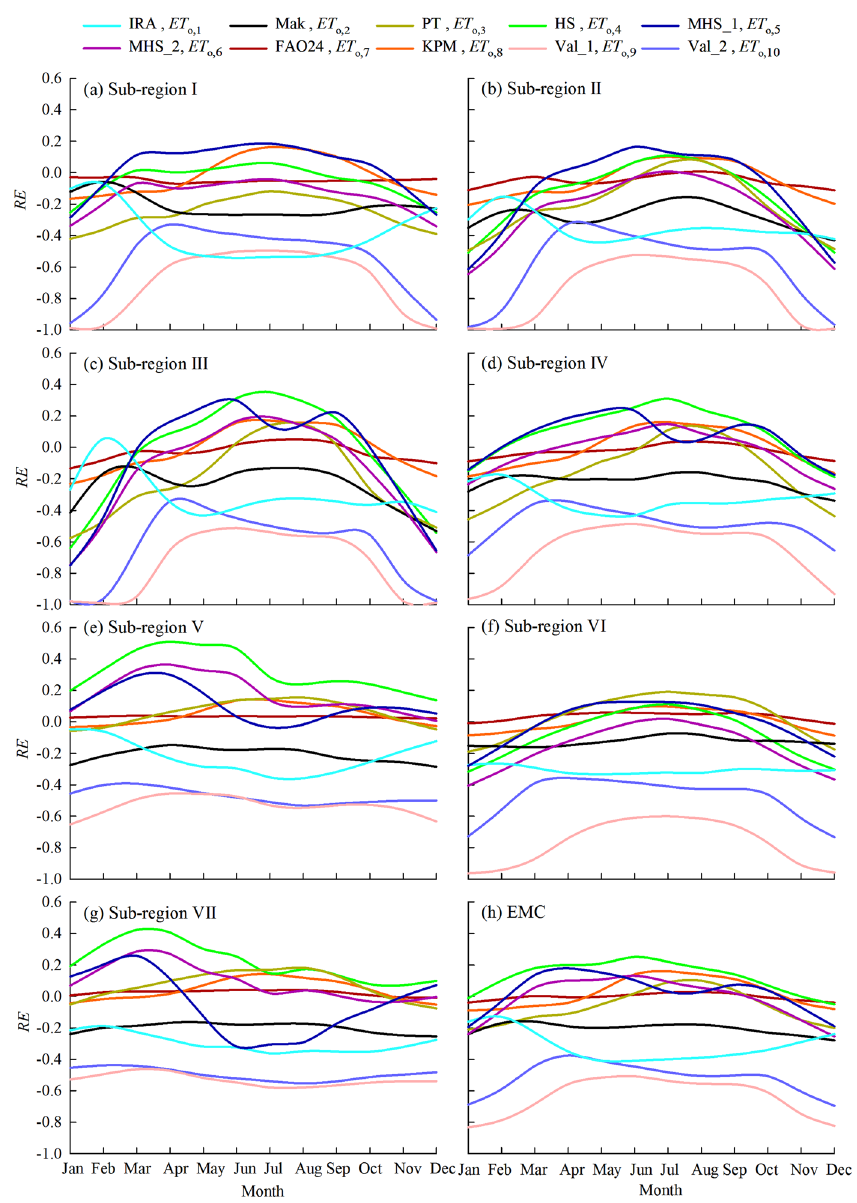
Figure 8. The temporal variations of RE values for multi-year mean monthly ET o,i in different sub-regions and Moreover, the RE values were mostly month-free (i.e., overall larger or smaller than ET o,s in most months of the year) when comparing different estimation methods. However, ET o,4 , ET o,5 , ET o,6 , ET o,7 and ET o,8 overestimated ET o,s in 10, 8, 7, 7 and 6 months of the year, respectively, which resulted to overestimated annual ET o . The RE val- ues for annual ET o,i ranked in an order of ET o,9 > ET o,10 > ET o,1 > ET o,2 > ET o,4 > ET o,3 > ET o,5 > ET o,6 > ET o,8 > ET o,7 , corresponding to the method order of Val_1 > Val_2 > IRA > Mak > HS > PT > MHS_1 > MHS_2 > KPM > FA O24. Each method overestimated or underestimated ET o in different months or the whole year when compared to FAO56-PM, but in the temperature type, the MHS_2 method was found to be the closest to FAO56-PM consid- ering. Although the MHS_2 method underestimated the ET 0,s by 24% in January, and 15% and 25% in November and December, but had a very low RE (2%) for the year when compared to the FAO56-PM method. Standard deviation. The spatial distribution of multiyear mean monthly standard deviation ( θ ) for ET o,i are illus- trated in Fig. S2. All of the ten ET o estimation methods showed larger θ values in the northern China (sub-regions I, II and III), although with different ranges of θ . There was a method order of ranges for θ , i.e., IRA < Val_1 < M ak < PT < MHS_2 < HS < FAO24 < MHS_1 < Val_2 < KPM. In general, a larger ranges of ET o,i corresponded to a larger ranges of θ , the IRA method had a smallest range of θ because it had a smaller range of ET o. In fact, this method largely underestimated ET o,s . The KPM method had a largest range of θ , which indicated the variation